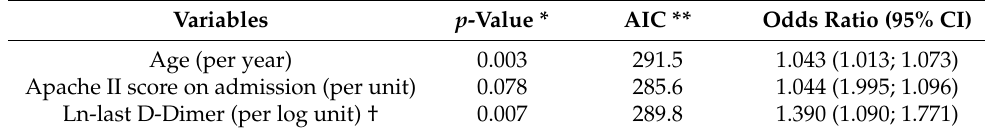
Table 4. Multivariate logistic regression for